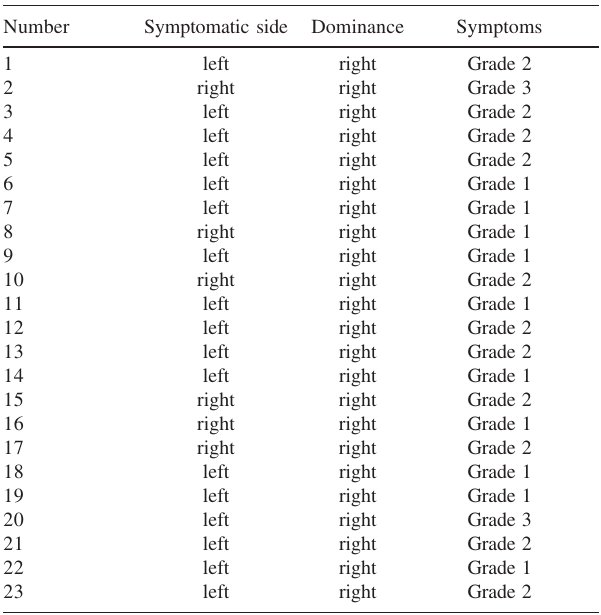
Table 1 - Functional limitation imposed by patients’